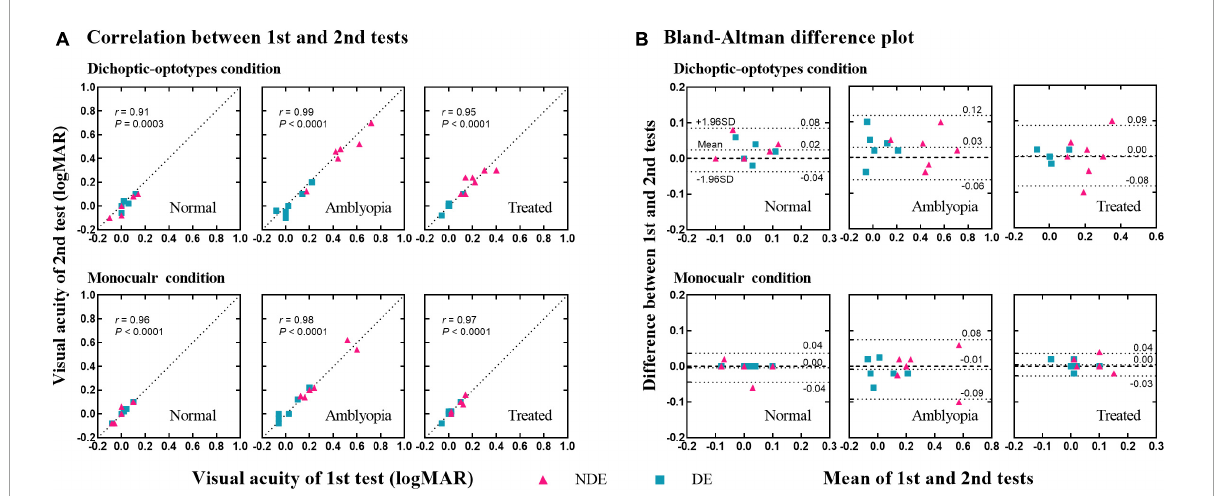
FIGURE4 Test-retest reliability of the dichoptic visual acuity chart. (A) Correlation between the 1st and 2nd tests. The dotted lines indicate the line of equality (1st test = 2nd test). (B) Difference in visual acuity between the 1st and 2nd tests (1st test–2nd test) as a function of the mean value of the two tests [(1st test + 2nd test)/2]. Three dotted lines indicate the 95% upper limits of agreement, the bias, and the 95% lower limits of agreement,